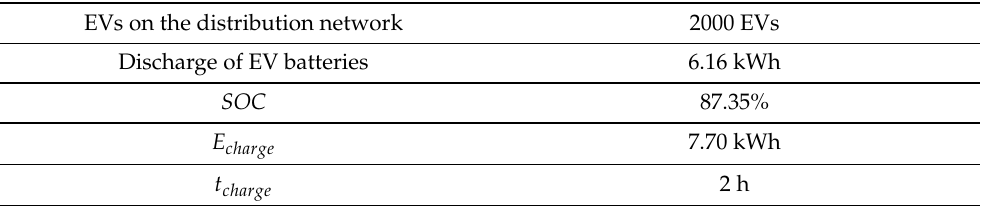
Table 1. Design characteristics considered. EVs on the distribution